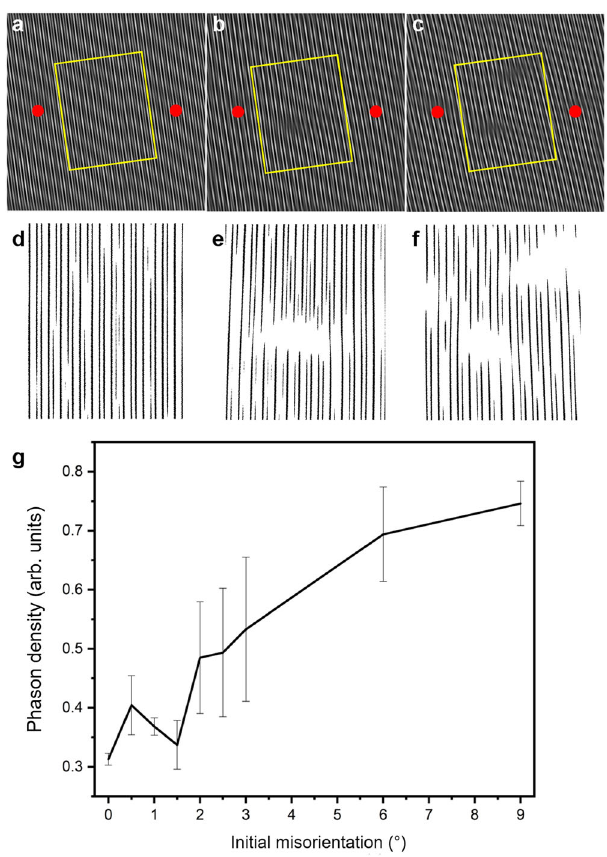
Fig. 7 Phason density of coalesced structure. Phason density modes obtained by fi ltering two pairs of Bragg peaks 7 from the merged quasicrystals with a 0°, b 3°, and c 9° of initial misorientations at timestep 4.0×10 5 from MD simulations. The red dots indicate the seed positions and the region highlighted with yellow rectangles is binarized for quantitative analysis of phason strain. d , e , and f correspond to a , b , and c , respectively. g Phason densities calculated as a function of initial misorientation between seeds, using the method introduced by Freedman et al. 7 . The phason density was determined from the binarized images based on the areas inside of the yellow rectangles for misorientations of multiple 0°, 0.5°, 1°, 1.5°, 2°, 2.5°, 3°, 6°, and 9° cases. For consistency of our results, we repeated analyses on different MD simulation datasets, which explains the origin of the error bars.